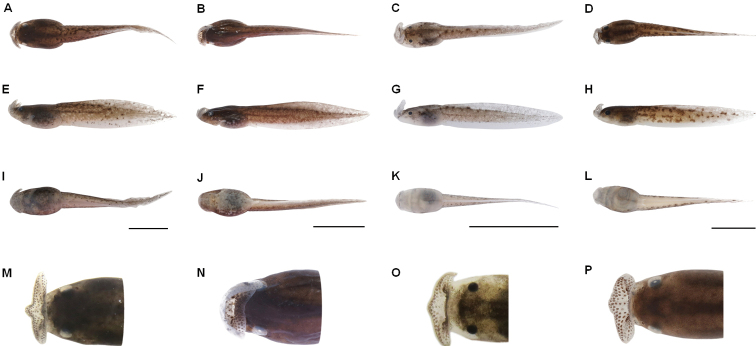
Tadpole specimens of four groups of three Megophrys species from Medog. A–D dorsal views of the low-middle-elevation tadpole CIBMT20170621 of M.
medogensis (Goser stage 35), the high-elevation tadpole CIBMT171001 of M.
medogensis (stage 27), tadpole CIBMT20170611 of M.
cf.
pachyproctus (stage 25), tadpole CIBMT170604 of Megophrys
yeae sp. nov. (stage 35), respectively E–H lateral views of the tadpoles, respectively I–L ventral views of the tadpoles, respectively. M–P dorsal views of head of the tadpoles, respectively. Scale bar for body view equal to 10 mm, and for head view 2 mm.